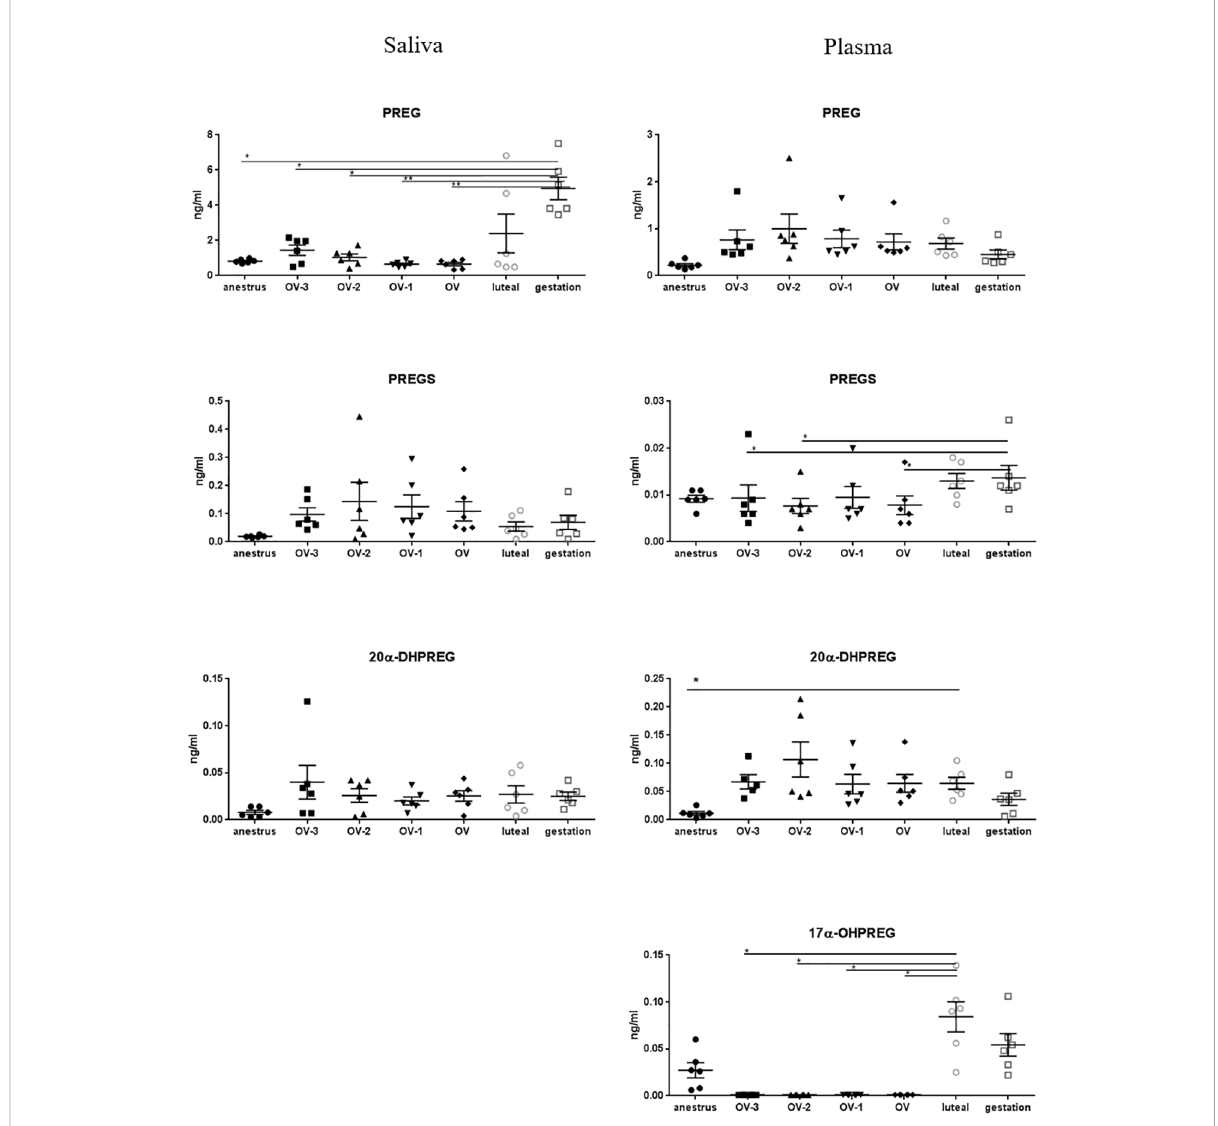
FIGURE 1 Gas chromatography coupled to tandem mass spectrometry (GC-MS/MS) measurements of the concentrations of pregnenolone (PREG), pregnenolone sulfate (PREGS), 20 a -dihydropregnenolone (20 a -DHPREG) and 17 a -hydroxypregnenolone (17 a -OHPREG) (ng/mL ± SEM) in mare saliva and plasma collected during anestrus, during follicular phase 3 days (OV-3), 2 days (OV-2) and 1 day (OV-1) before ovulation, the day when ovulation was detected (OV), during luteal phase 6 days post-ovulation (luteal), during gestation 18 days post-ovulation (gestation). For each steroid, the y-axis was standardized to the maximal concentration, so that the variations are easy-to-read. Statistical differences between physiological stages: * P < 0.05, ** P <